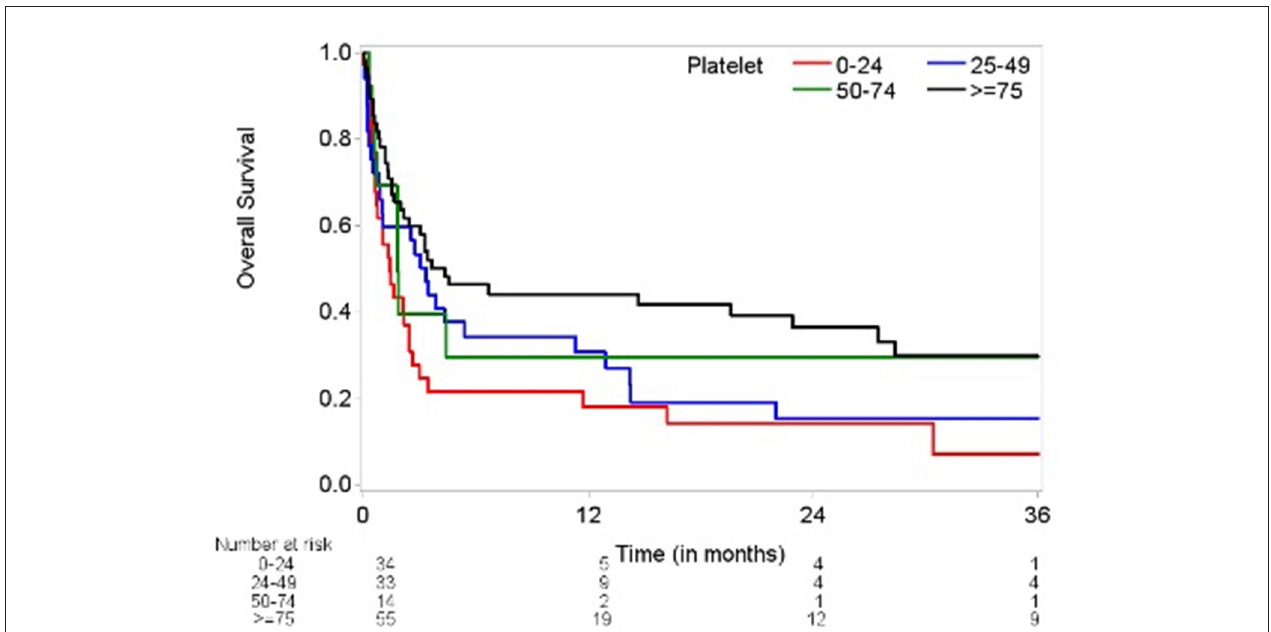
FIGURE 1 | Kaplan-Meier plot of overall survival by thrombocytopenia severity (log-rank test p = 0.0234). Time (months) on the x -axis marks time elapsed from pericardiocentesis. Overall survival (percentage) on the y -axis. Number at risk delineates the remainder of surviving patients at each time point in each group based on degree of thrombocytopenia and platelet count.